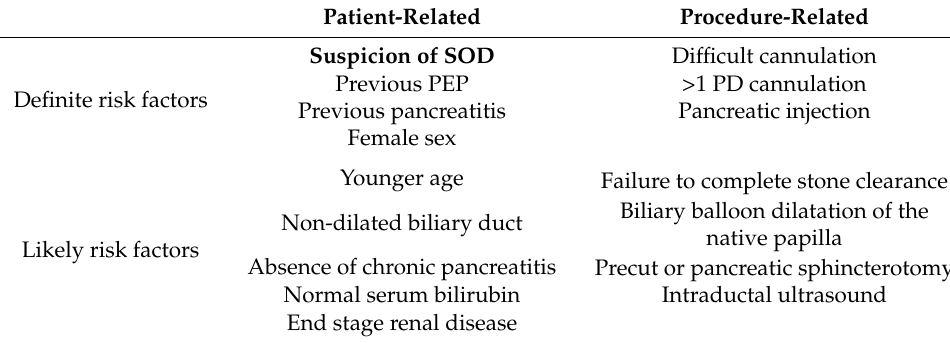
Table 3. Definite and likely procedure- and patient-related factors for post-ERCP pancreatitis [1]. PD: pancreatic duct. PEP: post-ERCP pancreatitis. SOD: Sphincter of Oddi